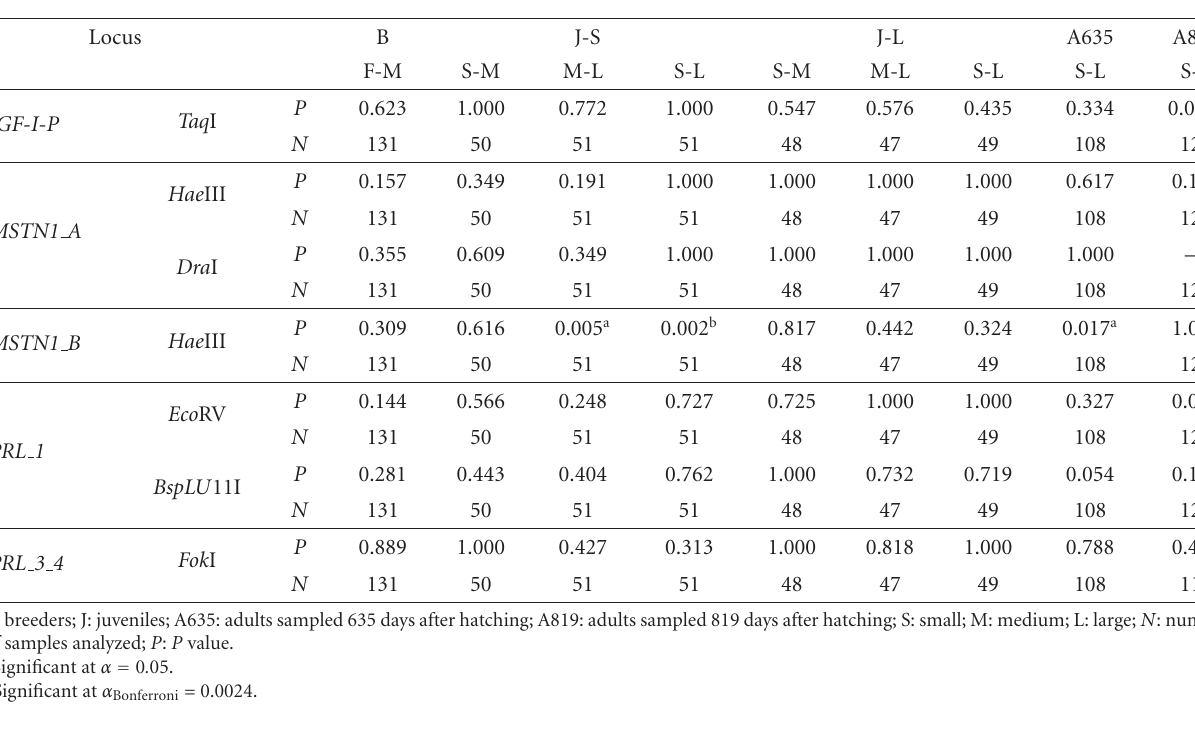
Table 5: Probability values ( P ) for exact tests for homogeneity of RFLP genotype frequencies in candidate genes between analyzed groups of S. aurata.